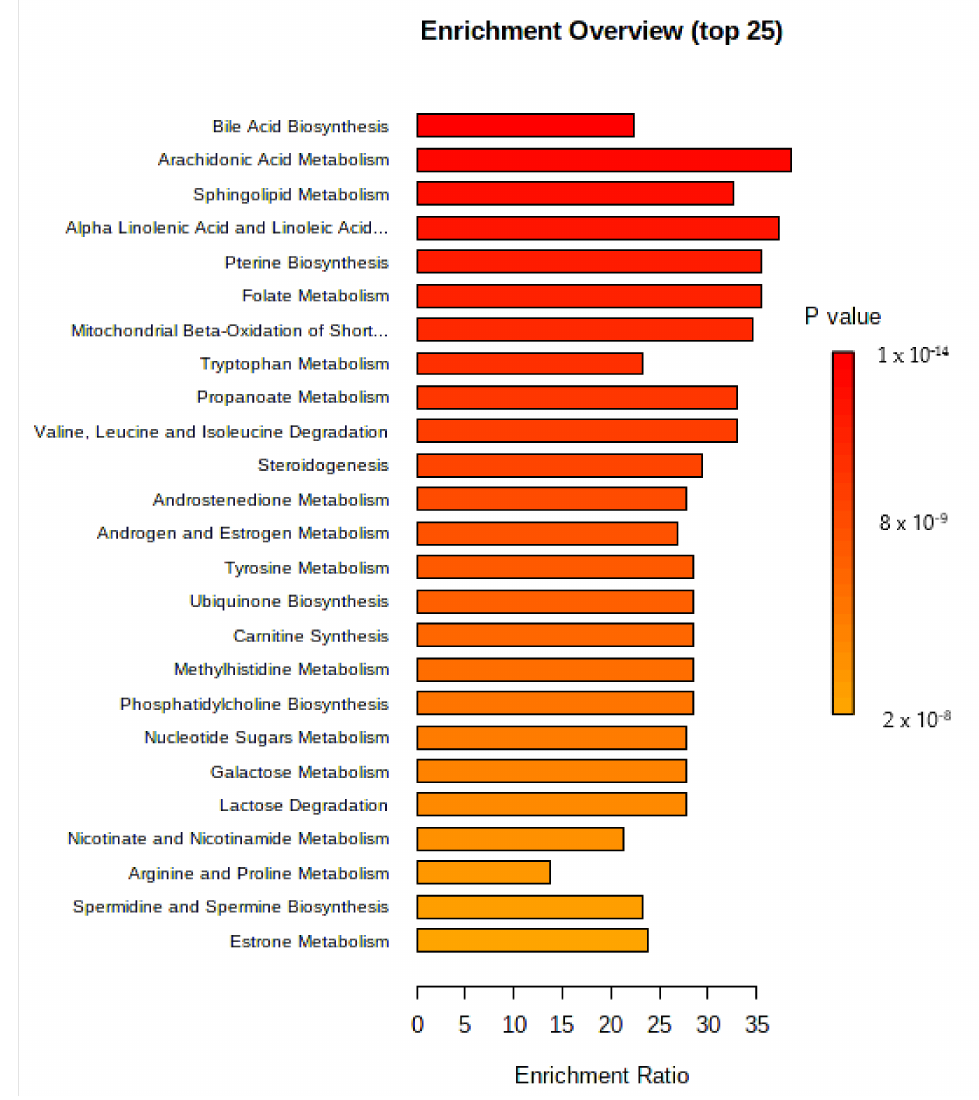
Figure 7. Bar graph with an overview of the analysis of enrichment of the metabolic 472 response against exposure to low concentrations of